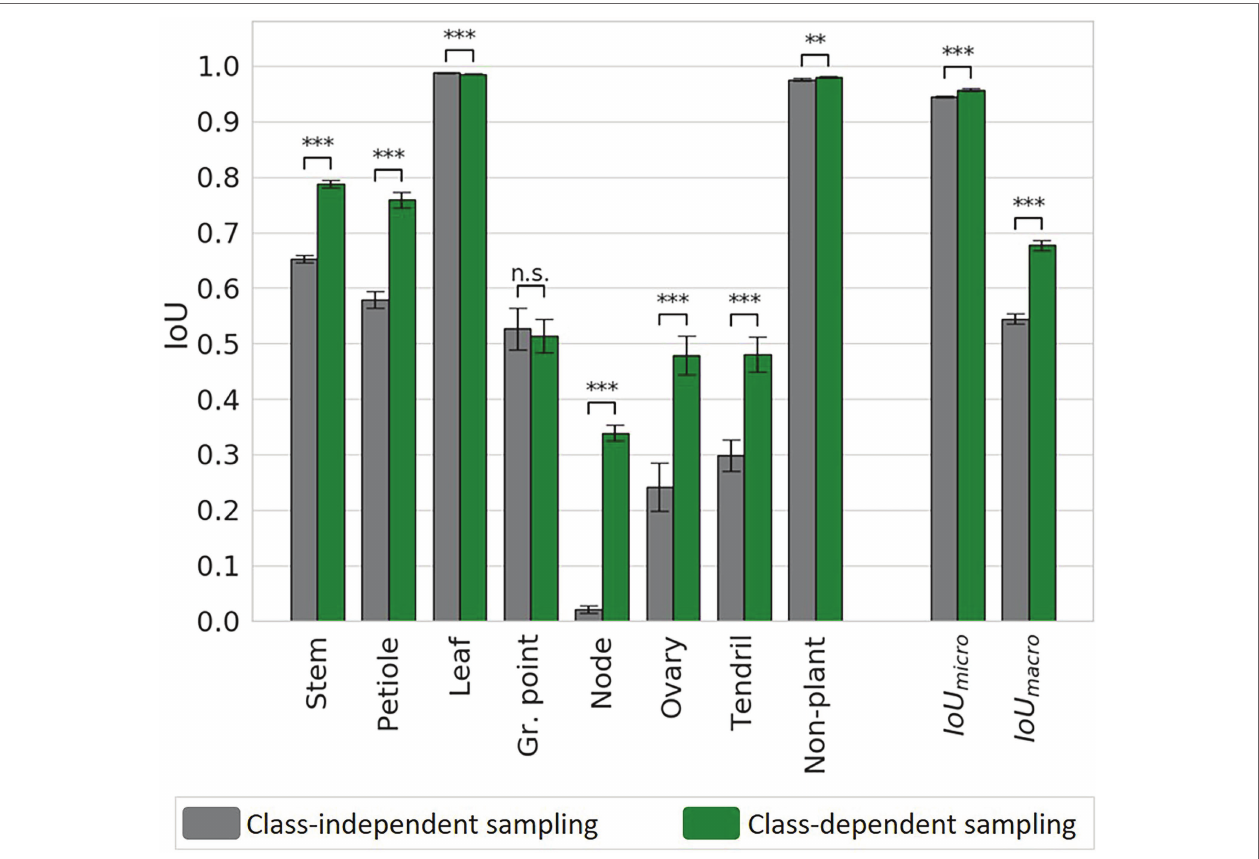
FIGURE 8 | IoU for the class-independent and the class-dependent sampling strategy based on the test set. Bars indicate the mean IoU and the error bars give the 95% confidence interval on the mean. The archs indicate the significance of the differences between the observed IoU